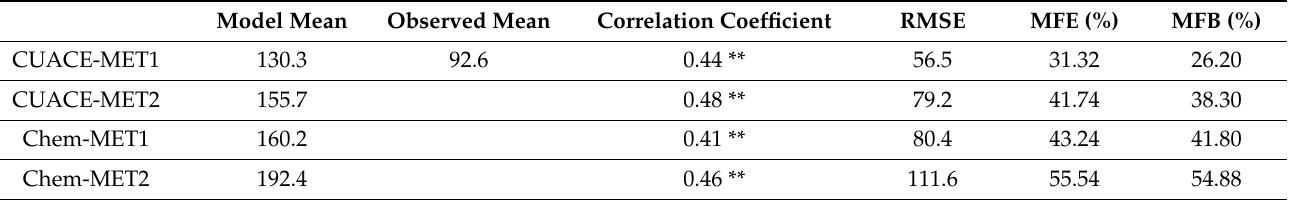
Table 5. Statistical analysis of PM 2.5 concentrations of four tests in the Pollution Episode I